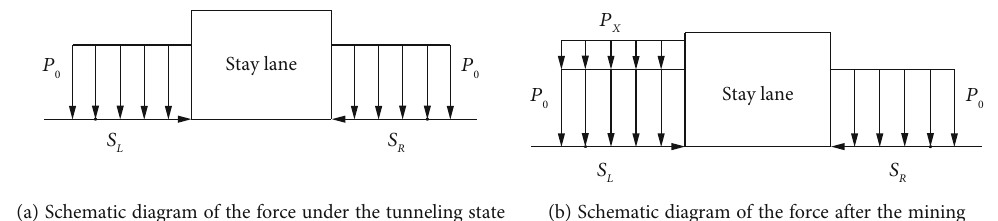
Figure 4: Simpli fi ed mechanical state model of the movement of the roof plate along the empty